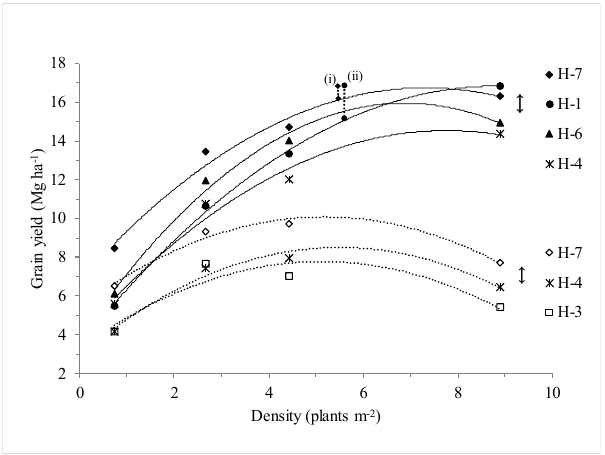
1 Values followed by the same letter did not differ significantly at p < 0.05 on least significant difference (LSD) obtained from analysis of variance [20] .